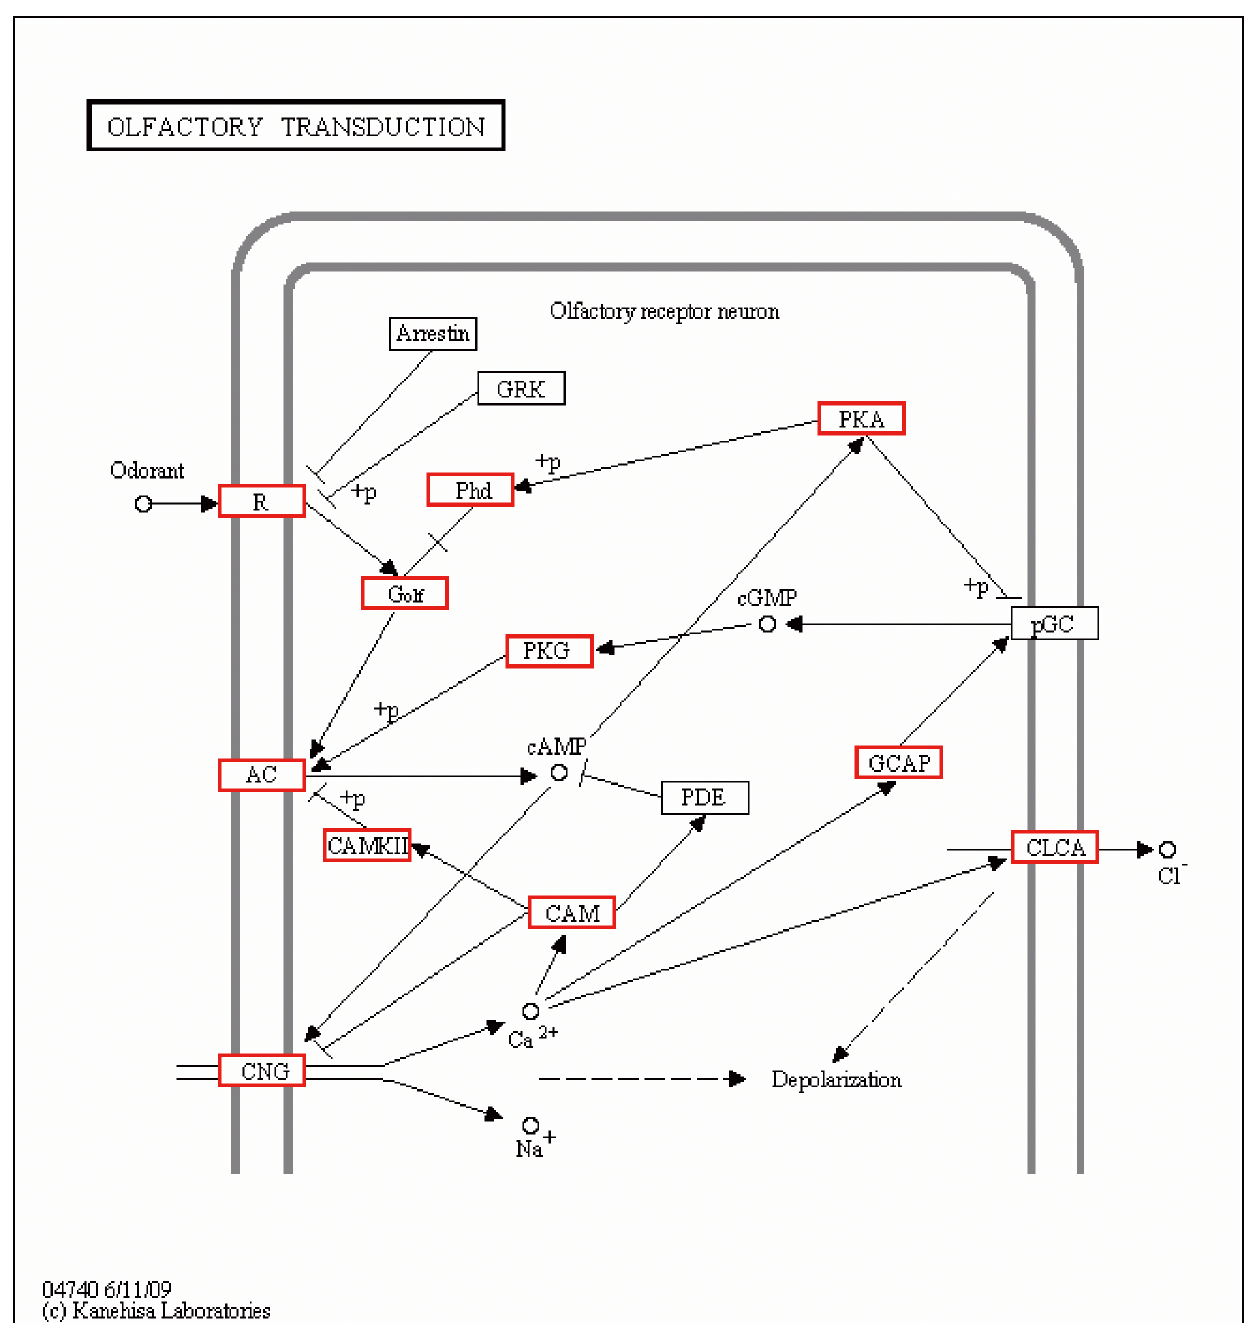
Figure 3. Functional annotation of Coilianasus genes using the KEGG pathway of olfactory transduction. The genes identified in the C. nasus transcriptomes are shown in red boxes. R: odorant receptor; G olf : G a olf -containing heterotrimeric G protein; AC: adenylate cyclase; CNG: cyclic nucleotide-gated cation channel; CLCA: calcium-activated chloride channel; GCAP: guanylyl cyclase-activating protein; Phd: phosducin; PKG: cGMP- dependent protein kinase; PKA: protein kinase A; pGC: particulate guanylyl cyclase; CAM: calmodulin; CAMKII: calcium/calmodulin-dependent protein kinase (CaM kinase) II; PDE: phosphodiesterase; Arrestin: arrestin; GRK: G protein receptor kinase.